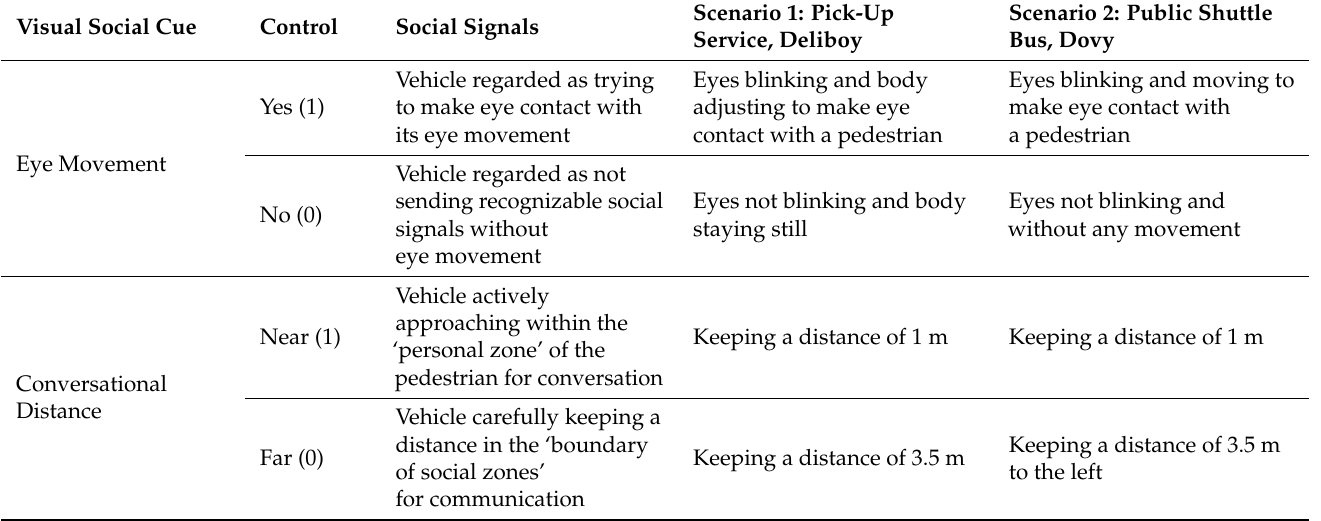
Table 2. Overview of